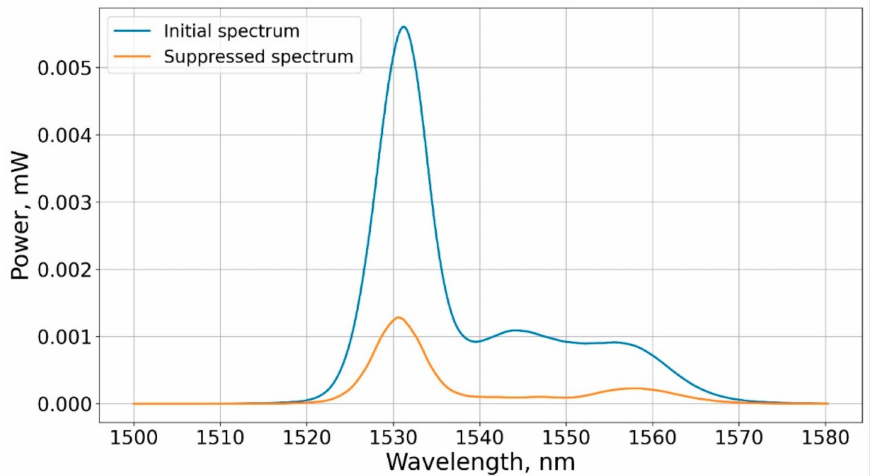
Figure 4. Transmitted radiation spectra for the IOM in the mode of regular operation and the radiation channeling